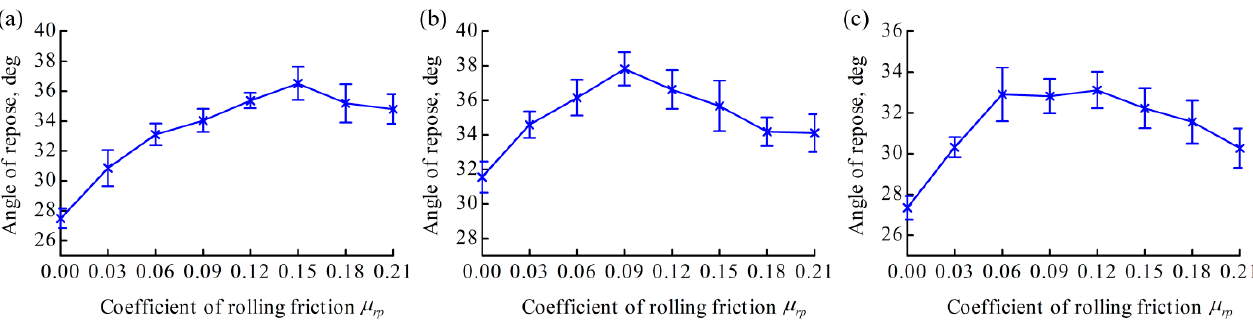
Figure 7. Influence of coefficient of rolling friction between seed particles on piling angle for three varieties: ( a ) Liangyu99, ( b ) Xianyu 335 and ( c ) Zhengda 999.